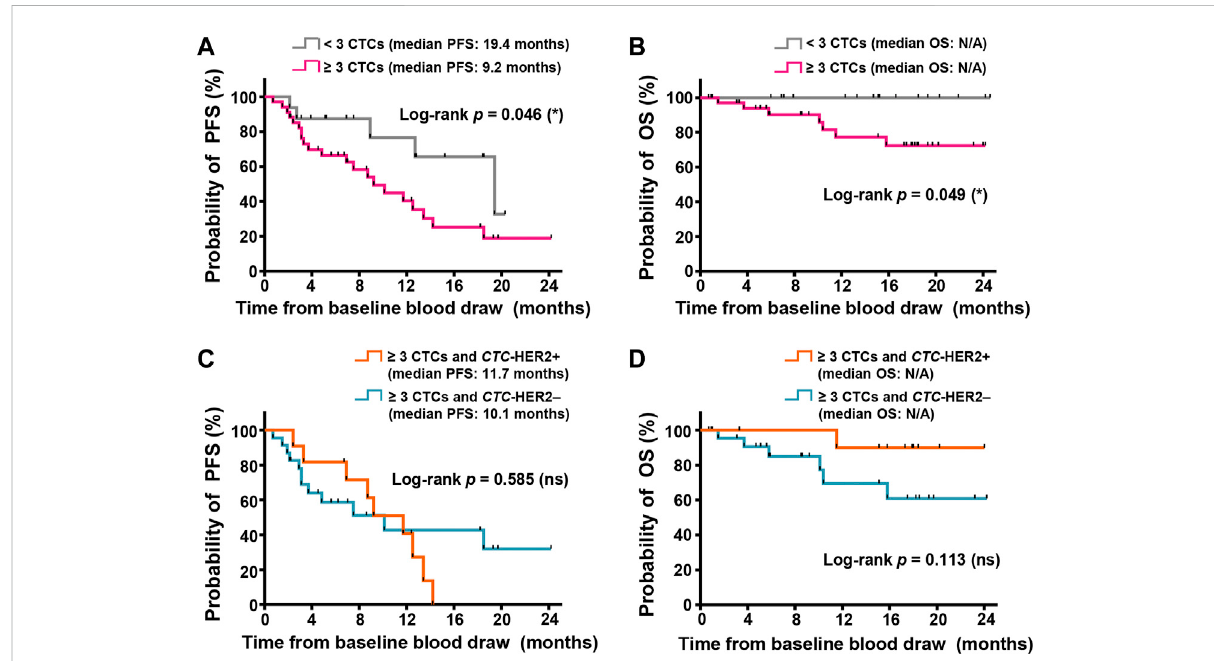
FIGURE 4 CTC enumeration and HER2 phenotyping on CTCs might correlate with survivals of advanced breast cancer, independent of molecular subtypes. (A,B) Kaplan-Meier plots of progression-free survival (PFS) (A) and overall survival (OS) (B) in the patients with various CTC enumeration ( ≥ 3CTCsinpink, < 3CTCsingray)from2.0 mlwholebloodatbaseline.InPFS (A) ,log-rank p =0.046,hazardratio(HR)ofprogression( < 3CTCsvs. ≥ 3 CTCs) = 0.387 (95% CI, 0.175 – 0.854); in OS (B) , log-rank p = 0.049; both are < 0.05 (signi fi cant, *). (C,D) Kaplan-Meier plots of PFS (C) and OS (D) in the cohort with ≥ 3 CTCs and various CTC-based HER2 status ( CTC -HER2+ in orange, CTC -HER2 – in dark green) from 2.0 ml whole blood at baseline. In PFS (C) , log-rank p = 0.585 (not signi fi cant, ns). In OS (D) , p = 0.113 (ns), HR of death ( CTC -HER2+ vs. CTC -HER2 – ) = 0.215 (95% CI, 0.048 – 0.959). N/A, median OS not yet reached.